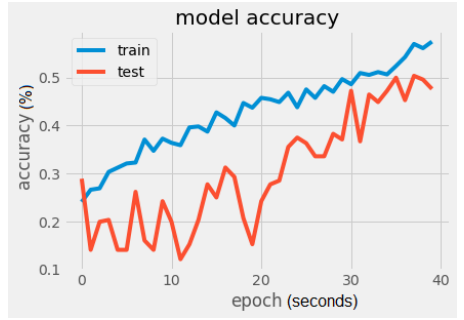
Figure 12. ResNet50 model accuracy.